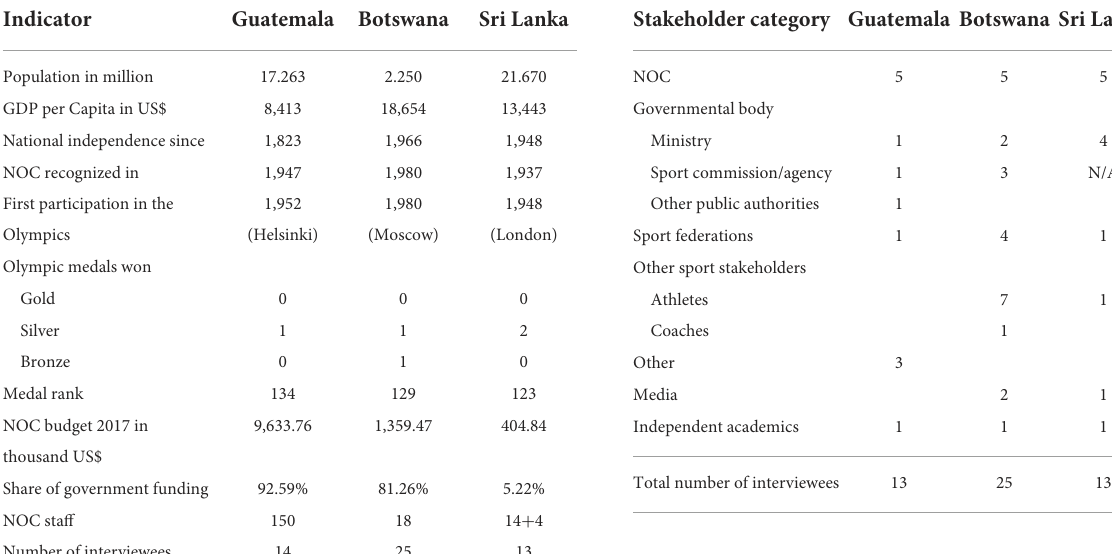
TABLE 1 Characteristics of the country case